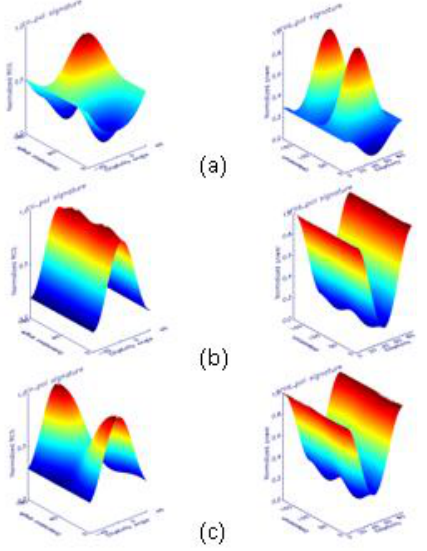
Figure 7: Co- and cross-polarimetric signatures using full polarimetric mode (a) urban region, (b) Agriculture field region, and (c) sea region.